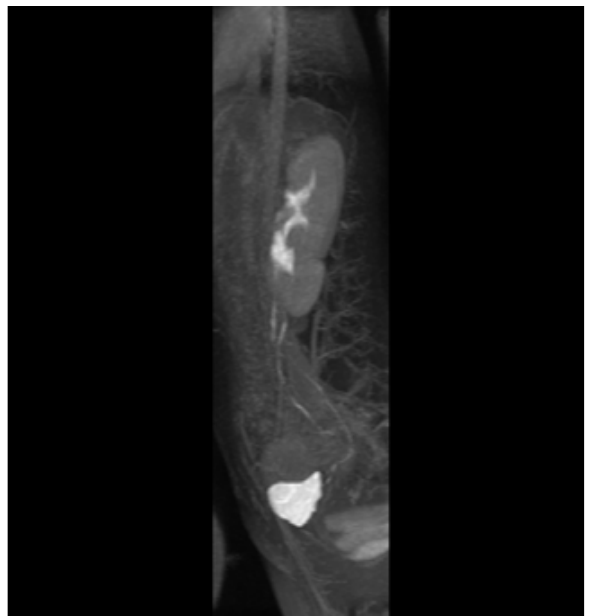
figure 2 - Magnetic ressonance image of abdomen and pelvis of a sagital reconstruction frame in T2. It is possible to observe the two independent collector systems without dilation with two ureters running to the